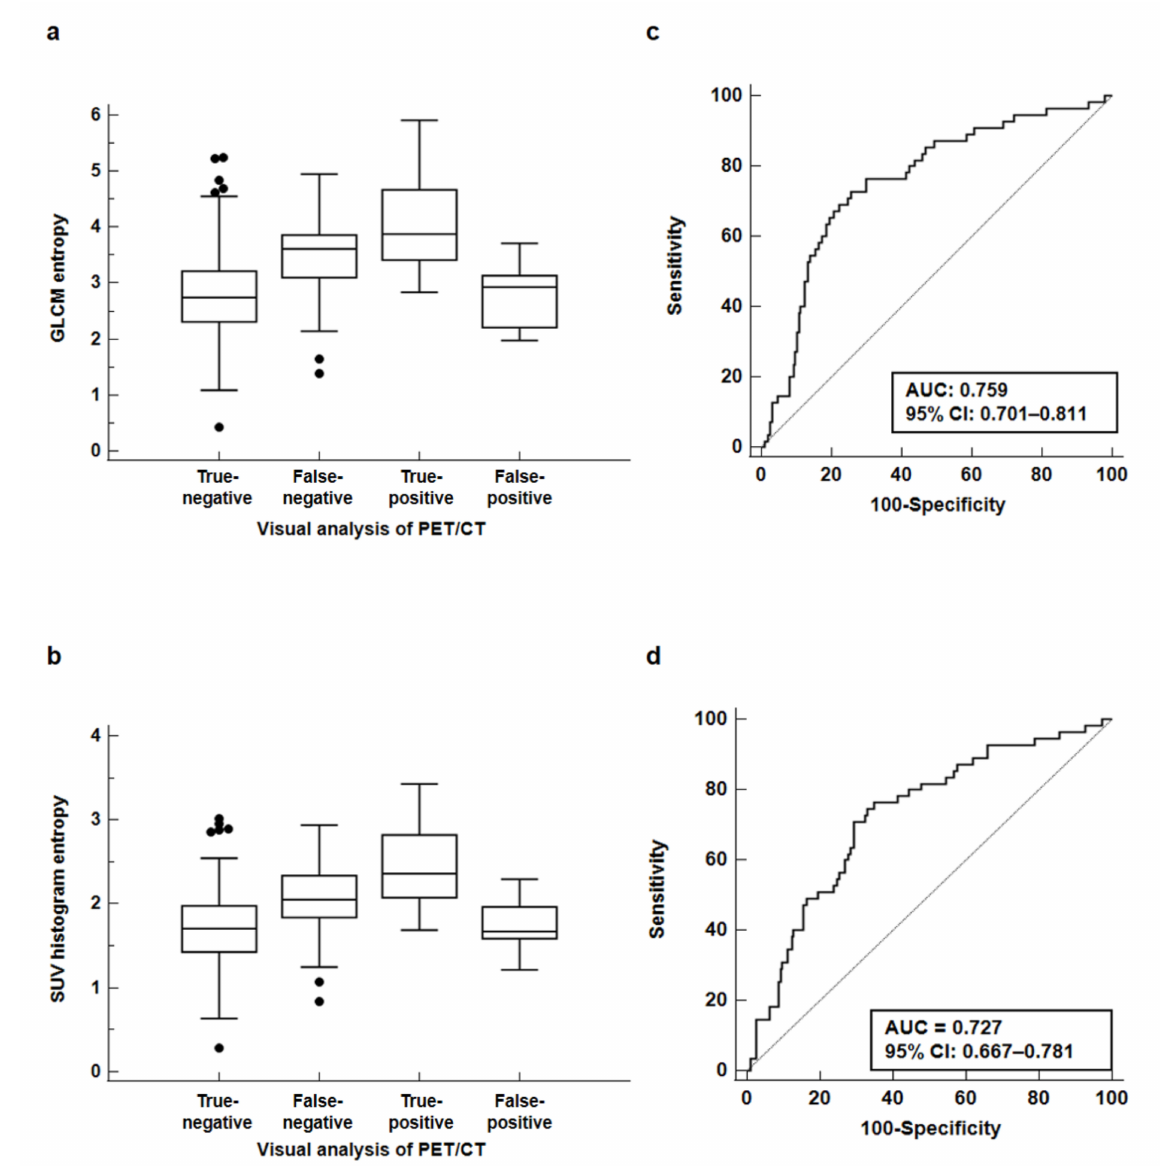
Figure 5. Distribution of the grey-level co-occurrence matrix entropy (GLCM entropy) ( a ) and the standardized uptake value (SUV) histogram entropy values ( b ) based on the results of the visual analysis of PET/CT. The receiver operating characteristic curves for GLCM entropy ( c ) and SUV histogram entropy ( d ) for predicting patients with axillary lymph node metastasis among the patients with negative findings on the visual analysis of